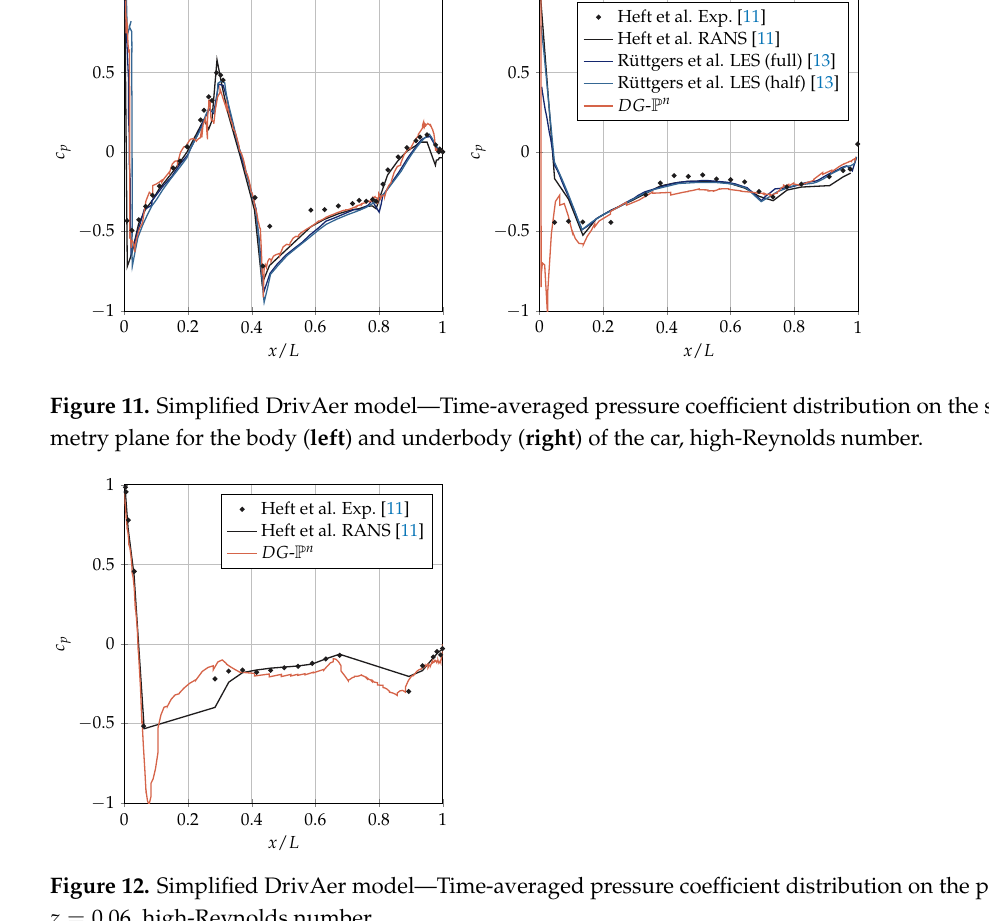
Figure 12. Simplified DrivAer model—Time-averaged pressure coefficient distribution on the plane z = 0.06, high-Reynolds number Figure 13 show the time-averaged pressure contours (top-left), the time-averaged pres- sure coefficient distribution on the windshield (top-right), the front side window (bottom- left) and the back window (bottom-right) for the low-Reynolds number case. The views and the scales of the pressure coefficient contours are the same used by Heft et al. [11] to ease the